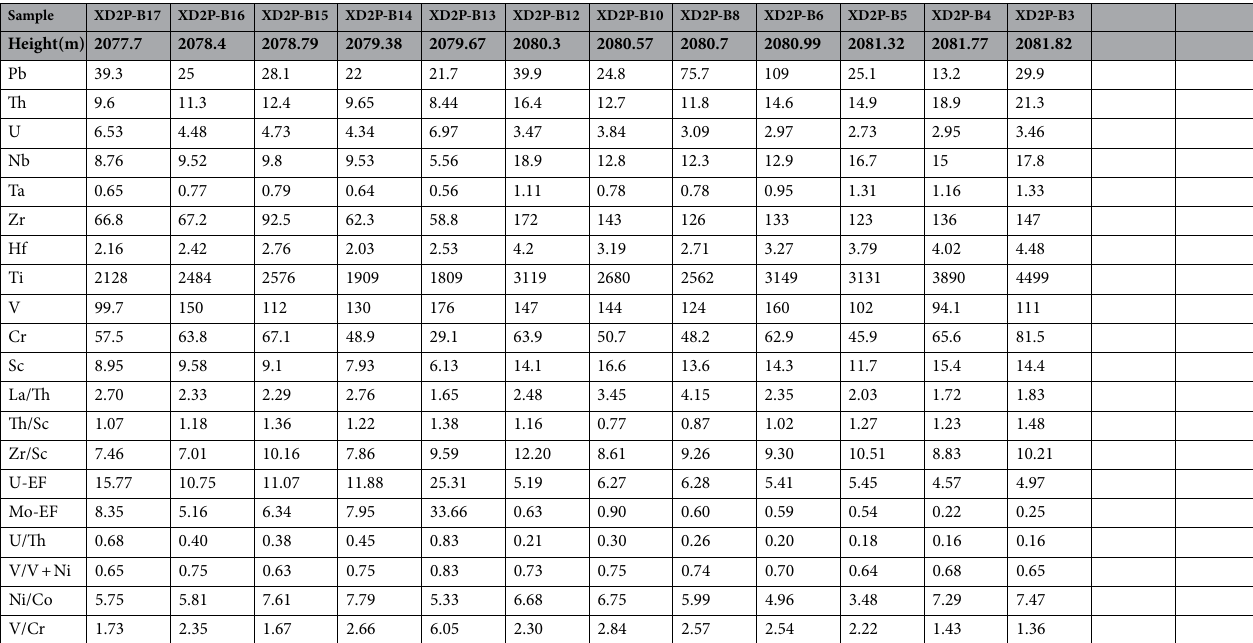
Table 4. Analytical data of some trace elements from the Wufeng-Longmaxi formations in the Xindi No. 2